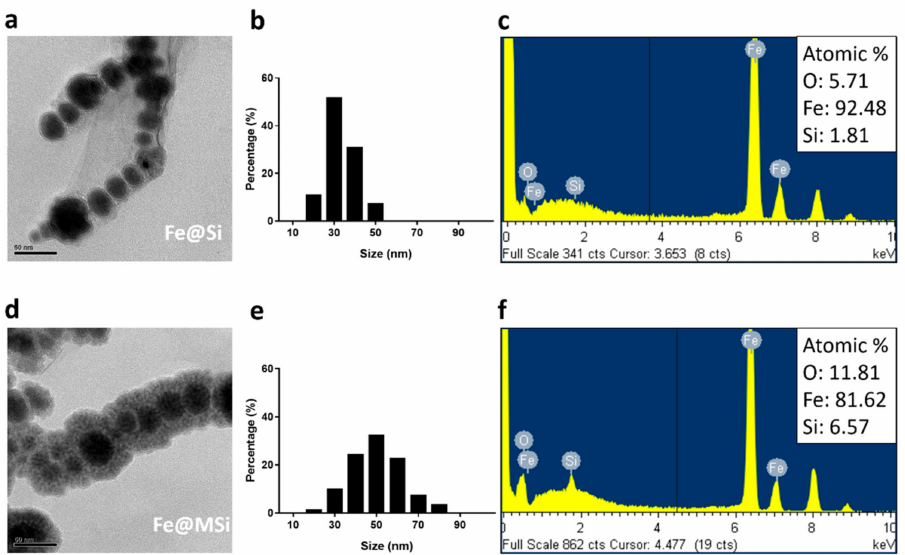
Figure 1. Characterization of ZVI@SiO 2 and ZVI@mSiO 2 nanoparticles (NPs). ( a ) Transmission electron microscopy (TEM) image of ZVI@SiO 2 NPs showed a thin and smooth surface of the silica shell. Scale bar = 50 nm. ( b ) The size distribution and average diameter of ZVI@SiO 2 was about 28.8 ± 7.1